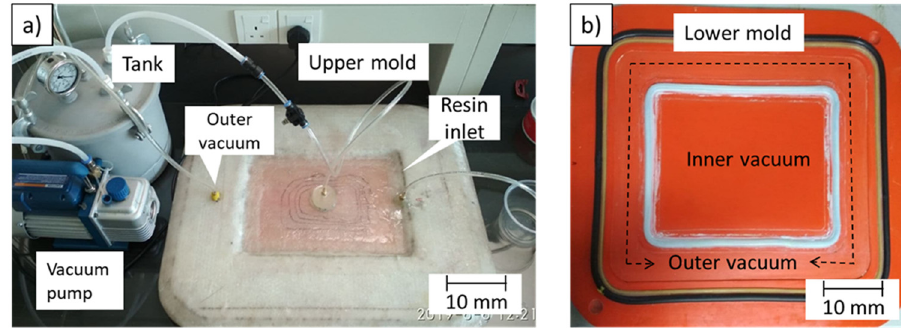
Figure 2: Experimental setup for VARTM process ( a ) upper mold and ( b ) lower